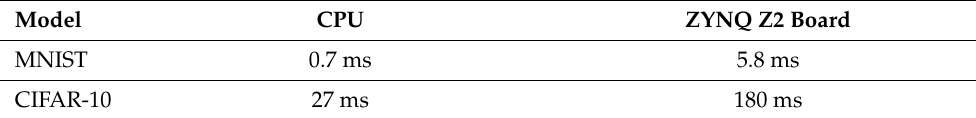
Table 3. Execution Time for different platforms and models, integer